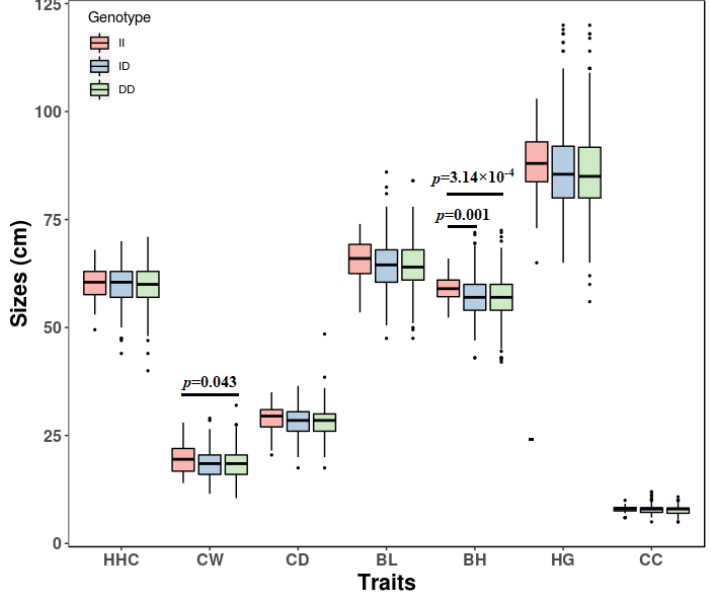
Figure 3. The association of goat SPAG17 17 bp indel and body measurement traits of Shaanbei cashmere goats. The p values were the results of post hoc multiple comparisons between genotypes. II, homozygote insertion genotype; DD, homozygote deletion genotype; ID, heterozygote genotype. HHC, height at hip cross; CW, chest width; CD, chest depth; BL, body length; BH, body height; HG, heart girth; CC, cannon circumference.